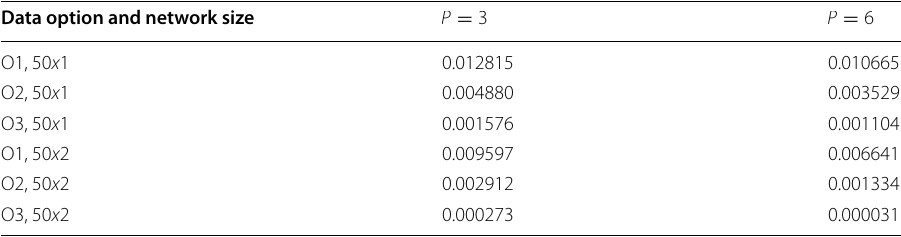
Table 1 Neural network training errors, noise-only training Data option and network